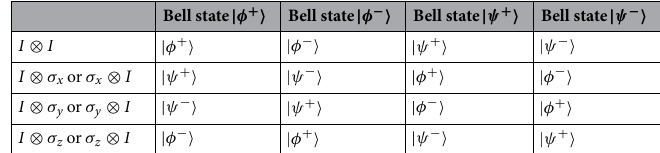
Table 2. An arbitrary Bell state will transform to another Bell state if a Pauli operator is applied on any one of its